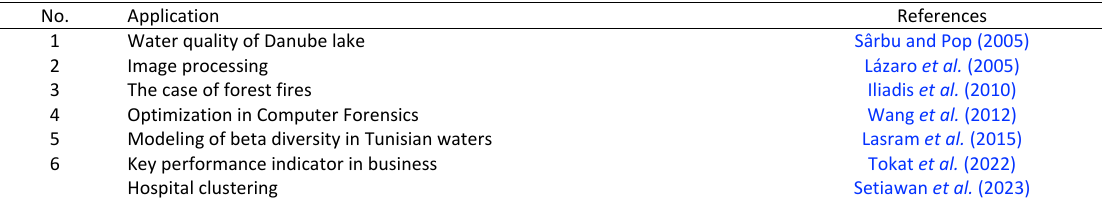
Table 2: Environmental variables used in the study